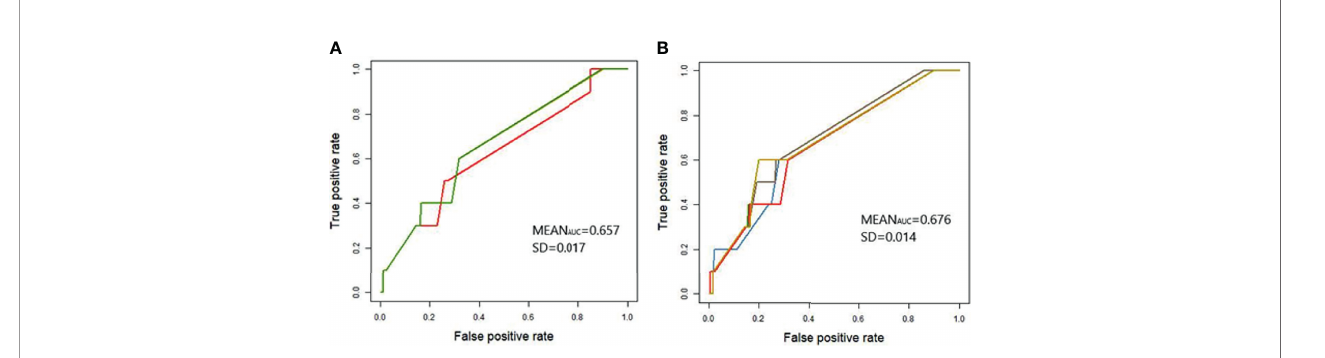
FIGURE 2 | Receiver Operating Characteristics (ROC) curve for application of genomic predictions from the study population to the validation population. GBLUP models were developed using the 142 (A) and 40 (B) SNPs with evidence of association with the case-control population 1; P < 5 × 10 -5 and P < 5 × 10 -7 , respectively. Genetic predictions were cross-validated in the validation population using a fi ve-fold strategy as described in Materials and Methods . Each curve represents one of the fi ve generated models and models might occasionally overlap. The average AUC and standard deviation (SD) across the fi ve cross-validations are included in each